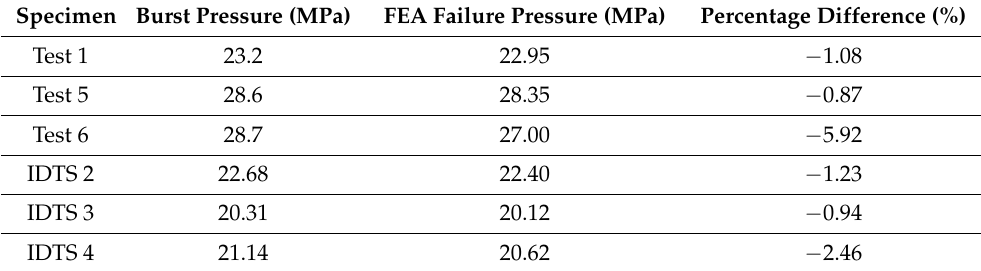
Table 7. FEM validation against full scale burst tests by Bjorney et al. and Benjamin et